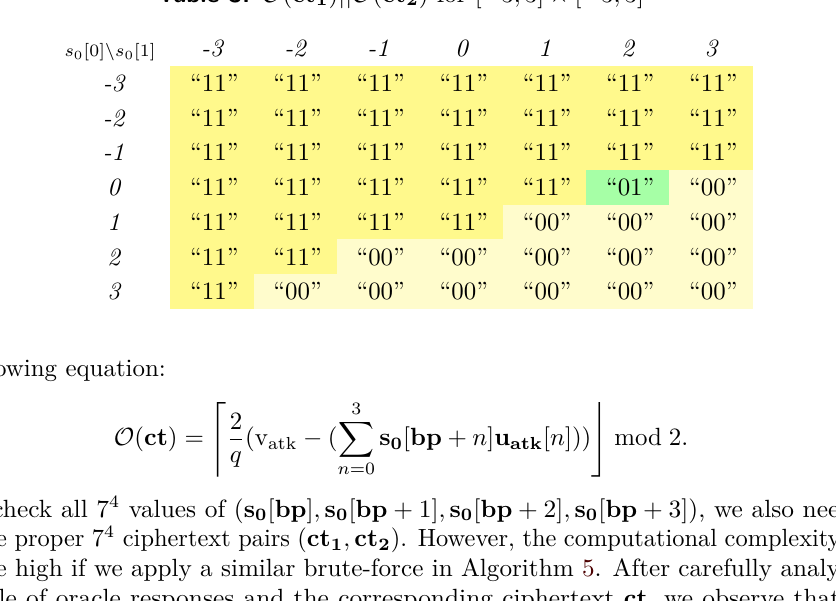
Table 3: O ( ct 1 ) ||O ( ct 2 ) for [ − 3 , 3] × [ − 3 , 3]